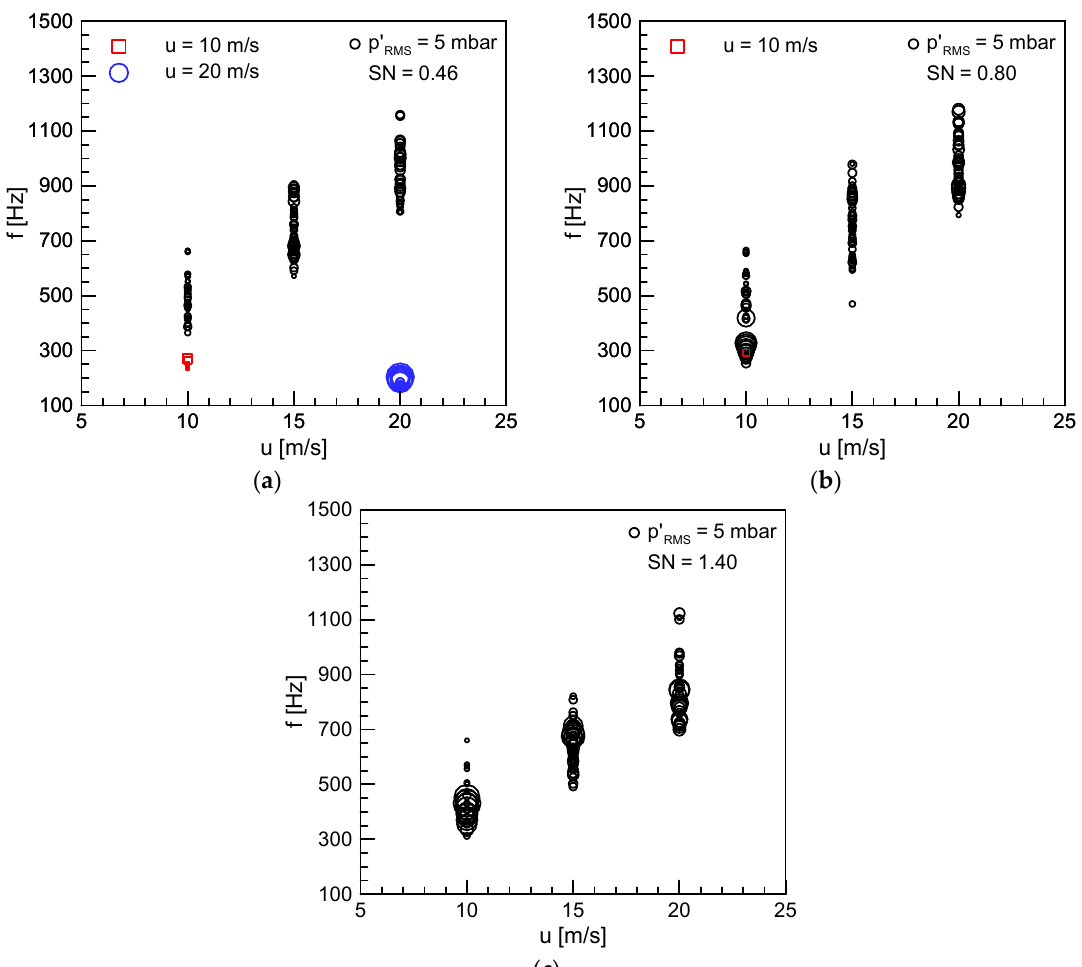
Figure 7. Dominant frequencies and their RMS values as a function of inlet mean velocity corresponding to the cases in Figure 5: ( a ) SN = 0.46, ( b ) SN = 0.80, and ( c ) SN = 1.40.